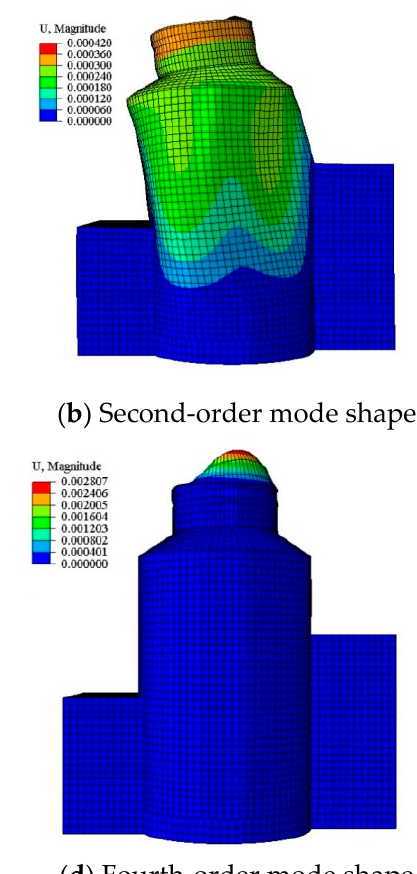
Figure 2. Finite element model of the raft foundation.